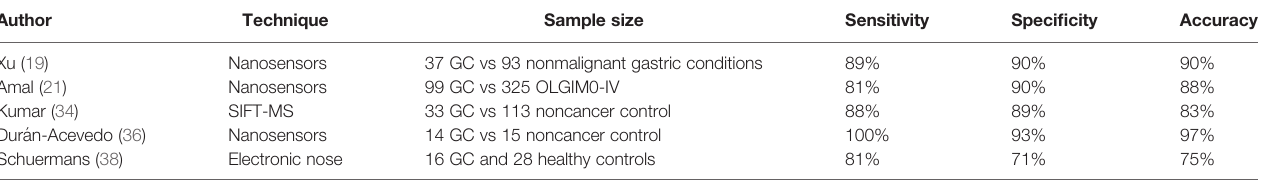
TABLE 6 | Studies included in the